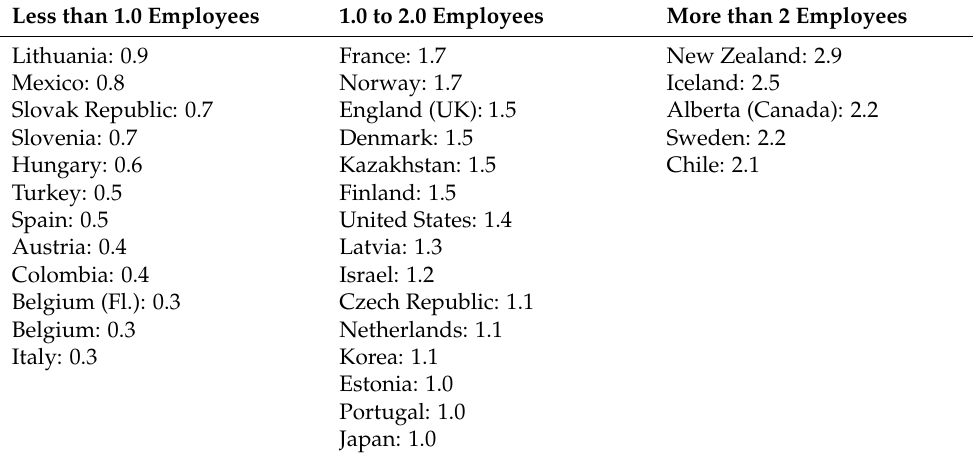
Table 1. Number of employed professionals supporting pedagogical work per ten teachers (ISCED 2), 2018.